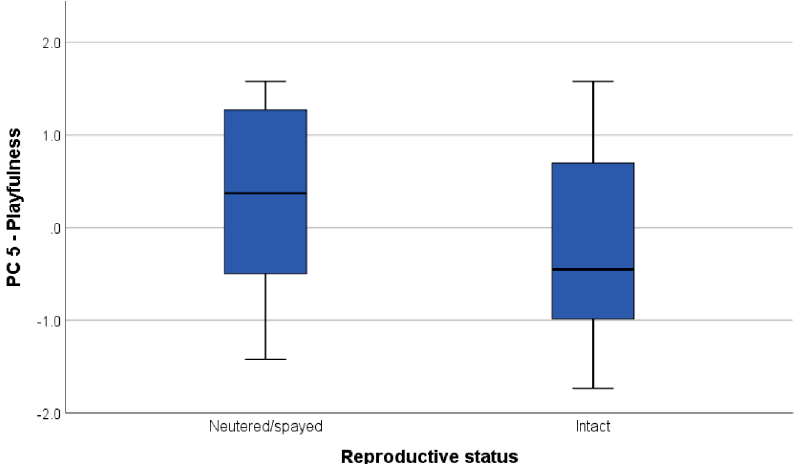
Figure 2. Boxplot showing the significant difference in ‘playfulness’ scores (component 5 of the PCA) between neutered/spayed or intact dogs.